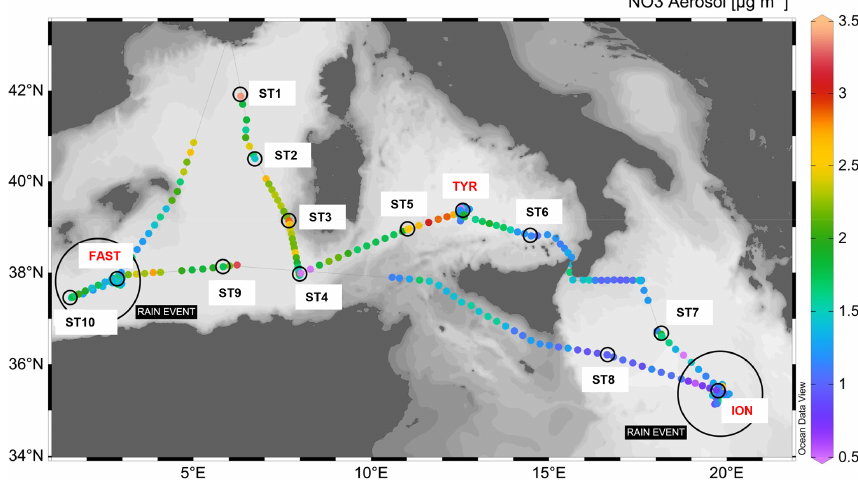
Figure 1. Nitrate (NO3) concentrations in the aerosols along the PEACETIME transect. The locations of two rain events are indicated by large black circles. Stations ST1 to ST4 were not sampled for nutrient analysis at a nanomolar level. Software for figure plot: Schlitzer (2021). Table 1. Main biogeochemical features/trophic conditions during the PEACETIME cruise. For TYR, ION and FAST sites investigated over several days, means ± SD are indicated. ITChl a : integrated total chlorophyll a (Chl a + divinyl Chl a ); IPP: integrated particulate primary production; IBP: integrated heterotrophic prokaryotic production. Integrations from surface to 200m depth for all data except IPP, integrated down to the depth of the 1% photosynthetically active radiation (PAR) level. nd: no